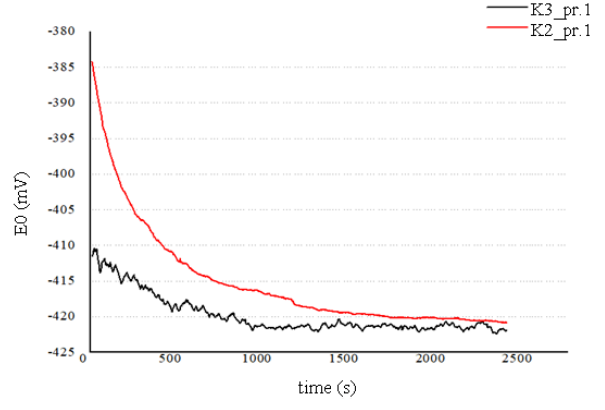
Fig. 14. Open circuit stationary potential as a function of time for samples number 2 and